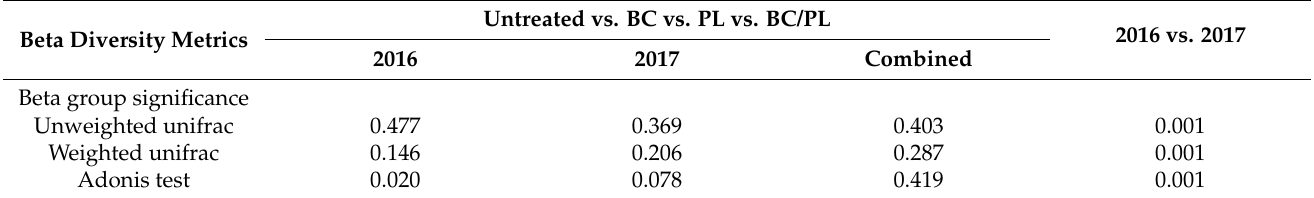
Table 5. Summary of the beta diversity metrics ( p